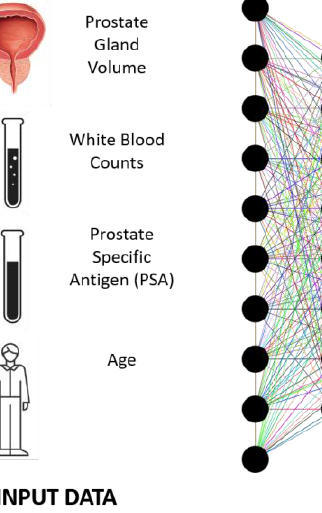
Figure 6. Usage of prostate-specific antigens (PSA) and other patient information to predict the chance of receiving a positive prostate biopsy.